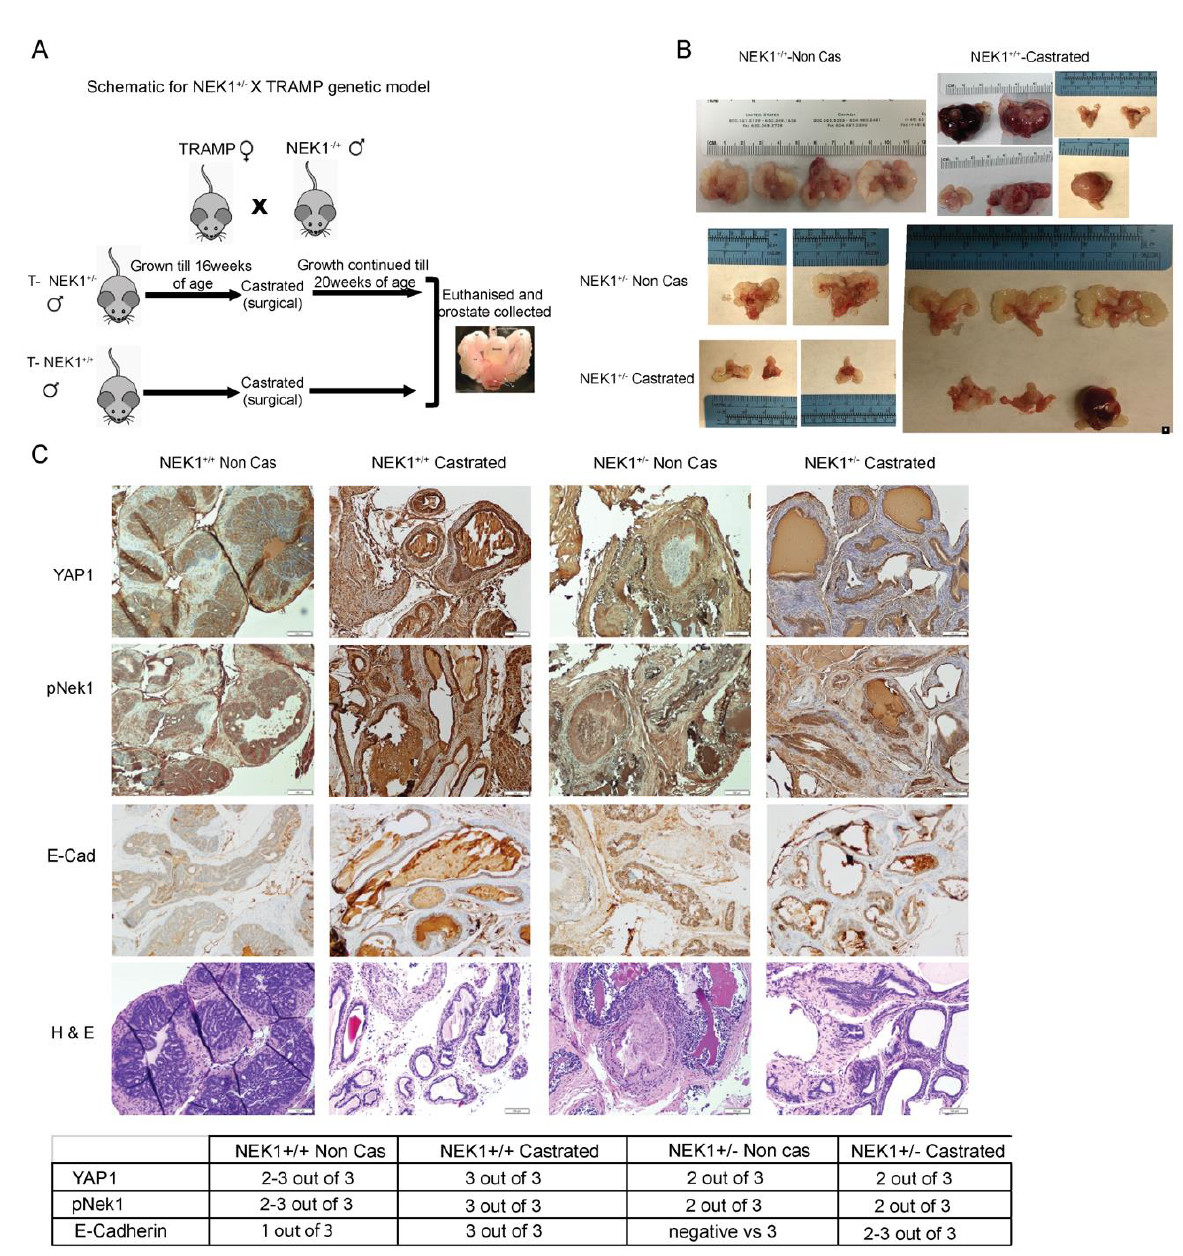
and CRPC. This suggests that NEK1 clearly plays a role in PCa progression.